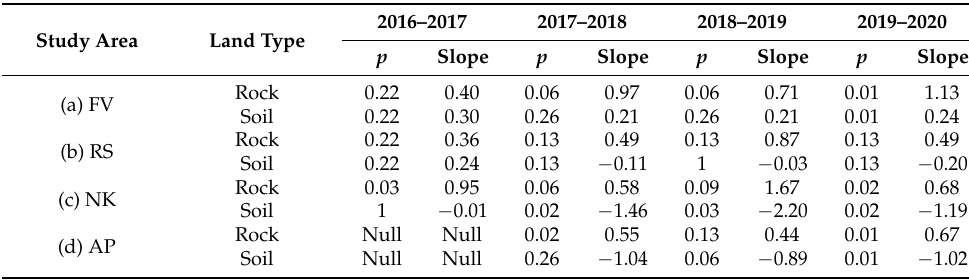
Table 4. Results of Mann–Kendall trend test performed of monthly-scale CR for two types of feature areas during the snow accumulation season (October to March of the following